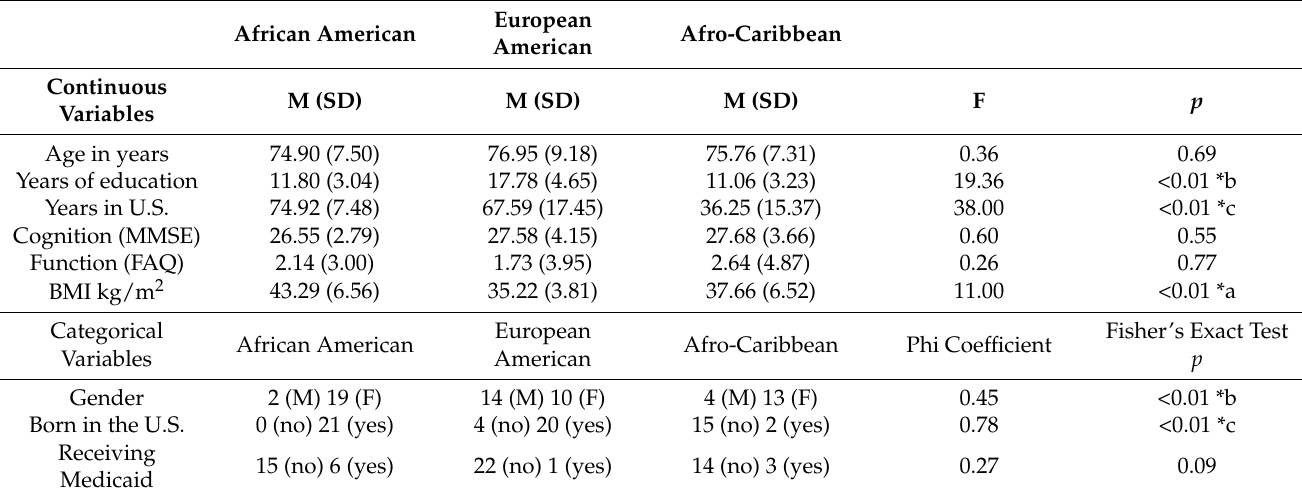
Table 1. Qualitative sample characteristics by ethnic group ( n =